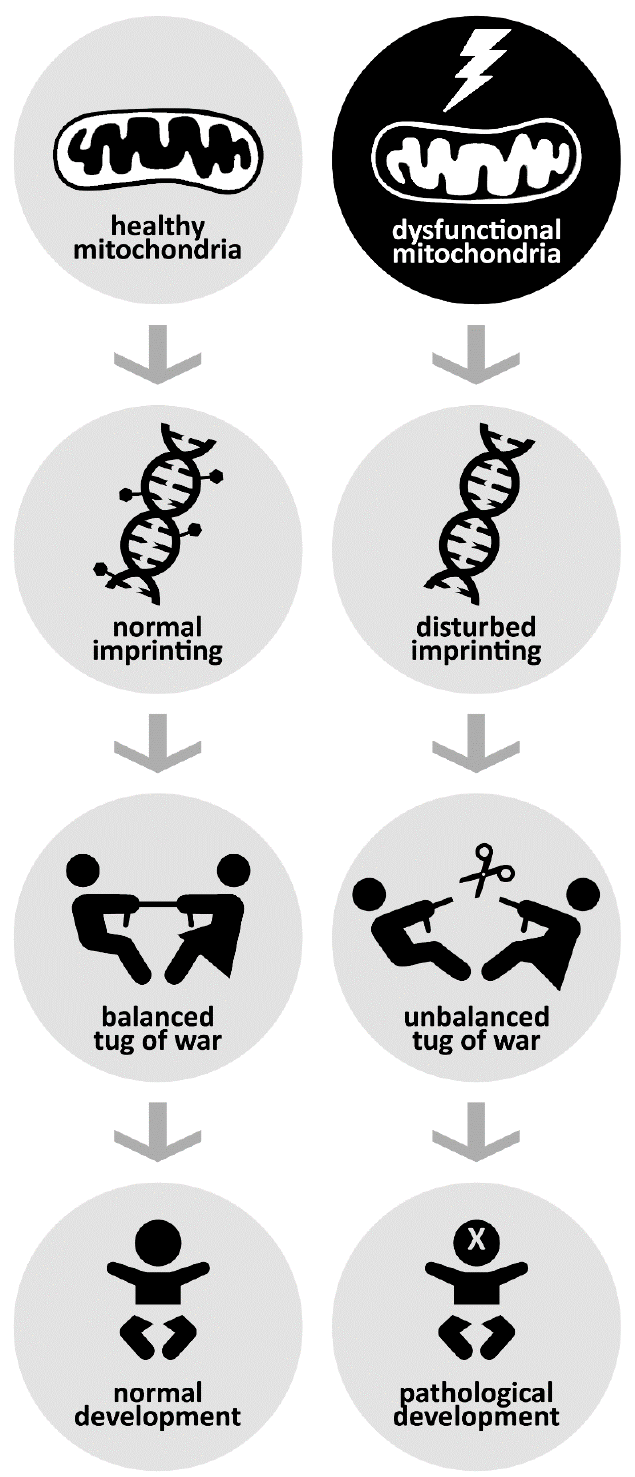
Figure 2. Healthy mitochondria ( left ) enable particular paternal and maternal genes to be silenced (imprinted) with a sort of tag. This results in a roughly balanced tug of war between parents over their genes’ expression in the child—which allows the child to develop roughly normally. Dysfunctional mitochondria ( right ) disrupt imprinting, upsetting the balance and increasing the child’s risk of physical and mental disorders. (Icons adapted from the Noun Project. Lightning: TTHNga; DNA: Léa Lortal; Tug of War: ProSymbols; Scissors, Baby: David.)